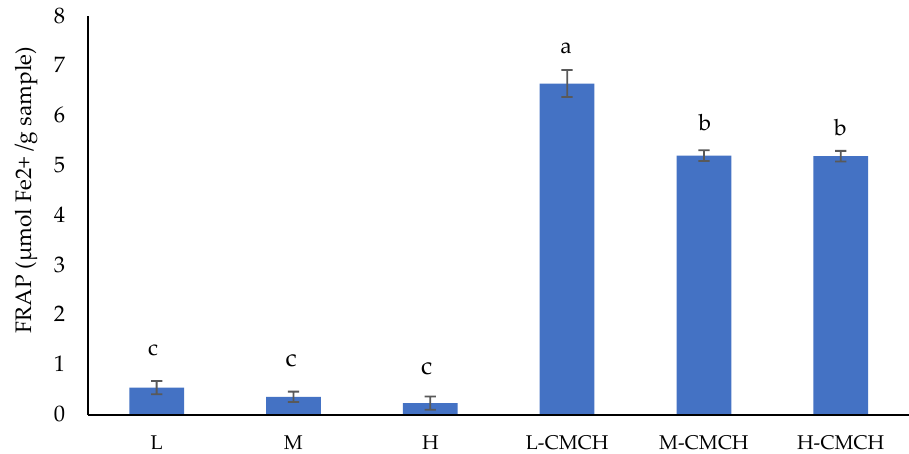
Figure 4. Ferric reducing antioxidant power (FRAP) of L, M, H, L-CMCH, M-CMCH and H-CMCH. Different letters (a-c) indicate significant difference between treatments ( p ≤ 0.05).